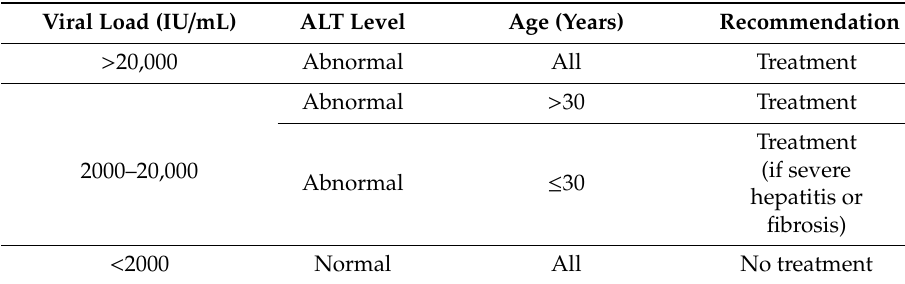
Table 3. NICE treatment indications for chronic HBV-infected patients.